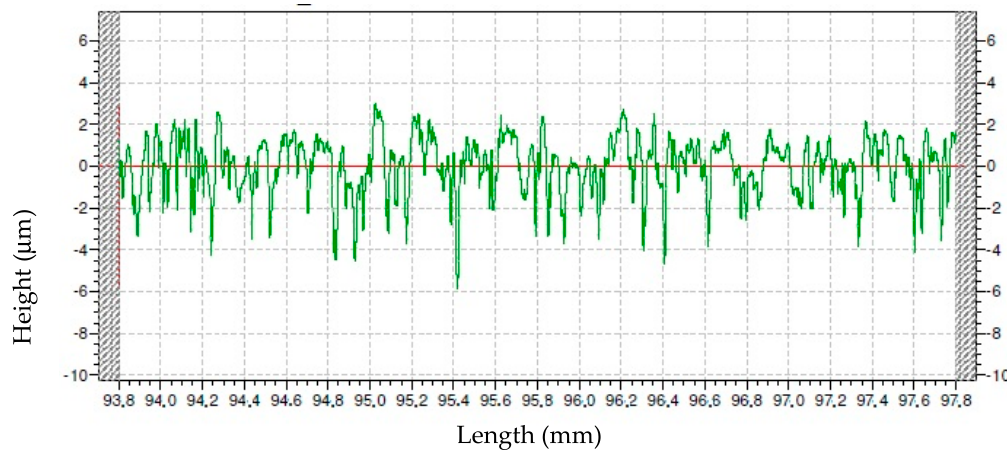
Figure 14. Graphical representation of the measured profile of the WEDM cam in Segment 1.